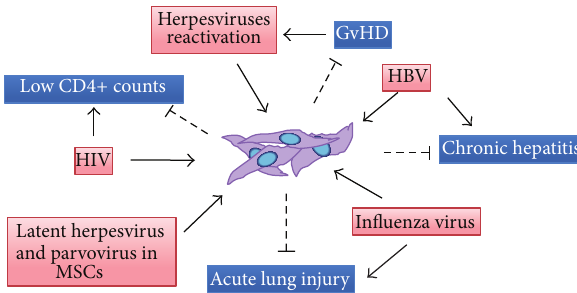
Figure 1: The proposed double-edge sword effect of using MSCs as a treatmentforviraldiseases.Severaltransplant-relatedcomplications and viral-associated diseases such as GvHD, low CD4+ numbers, ALI, and chronic hepatitis have been successfully improved